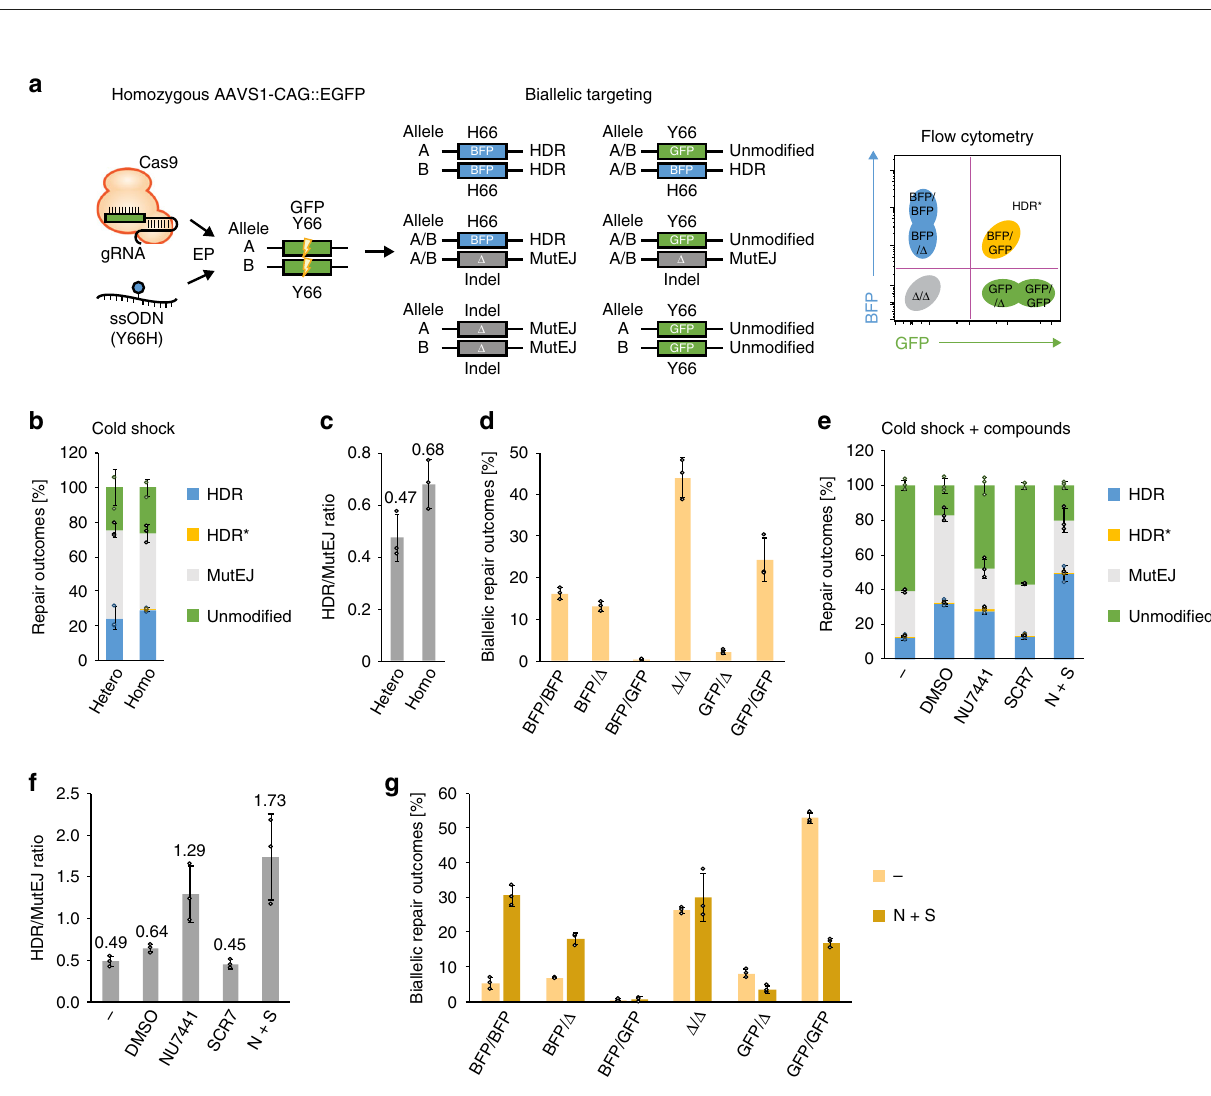
Fig. 3 Combining DNA repair modulation and cell-cycle synchronization synergistically enhances HDR in iPS cells. a List of compounds tested with their function on molecular targets (top), and experimental timeline of compound pre- (4 h) and post-EP (48 h) treatment (bottom). b Screening of compounds under cold shock condition [C], including untreated ( − ) and DMSO treated (DMSO) controls, showing the effect on DNA repair outcome frequency. Data are presented as the mean ± S.D. of three biological replicates. c Ratio of HDR/MutEJ repair outcomes measured in b . d Combination treatment of NU7441 and SCR7 under cold shock condition [C], and the effect on repair outcome frequency. Data are presented as the mean of two biological replicates, except N + S is presented as the mean ± S.D. of four biological replicates. e Ratio of HDR/MutEJ repair outcomes measured in d . f Combination treatment of cell- cycle inhibitor XL413 (XL) post-EP (24 h) and N + S pre- (4 h) and post-EP (48 h) under normal culture conditions [A] or cold shock [C]. Data are presented as the mean ± S.D. of three technical replicates for each respective treatment. g Ratio of HDR/MutEJ repair outcomes measured in f . h Representative FACS plots of cells treated with XL413 (XL) and N + S under normal [A] (left) and cold shock [C] (right) conditions, as tested in f . Source data are provided as a Source Data fi le.